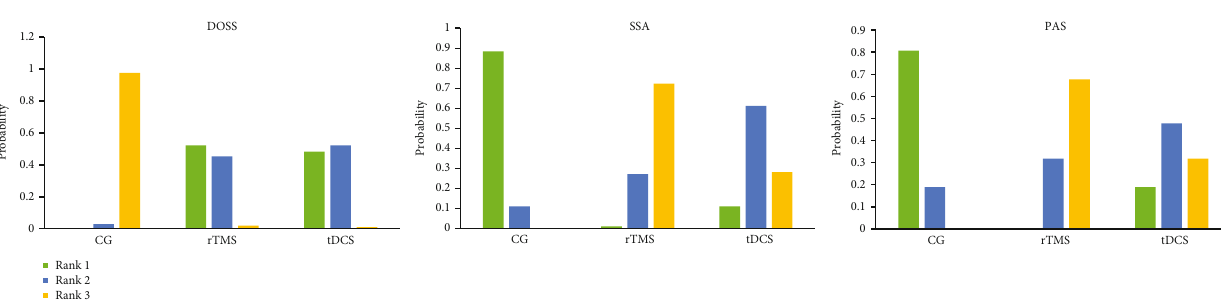
Figure 9: Probability ranking of outcomes of di ff erent Table 4: Subgroup analysis of primary outcomes.